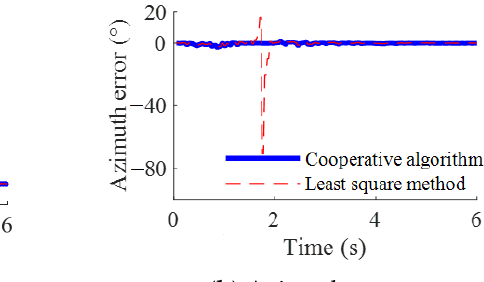
Figure 8 . Location results under condition (a).